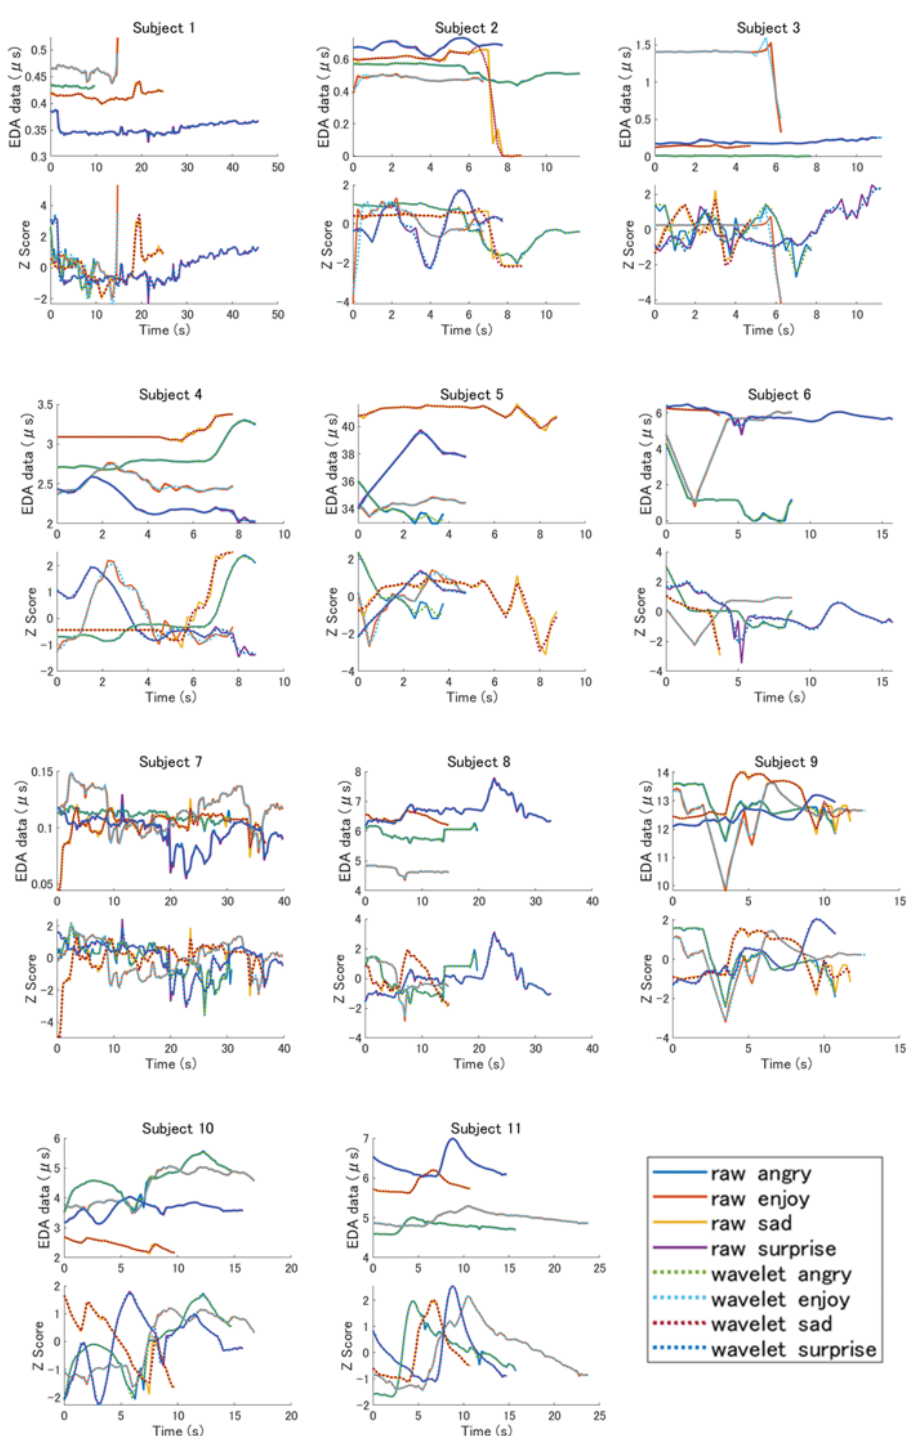
Figure 4. Raw and wavelet transferred data, and z scores of all